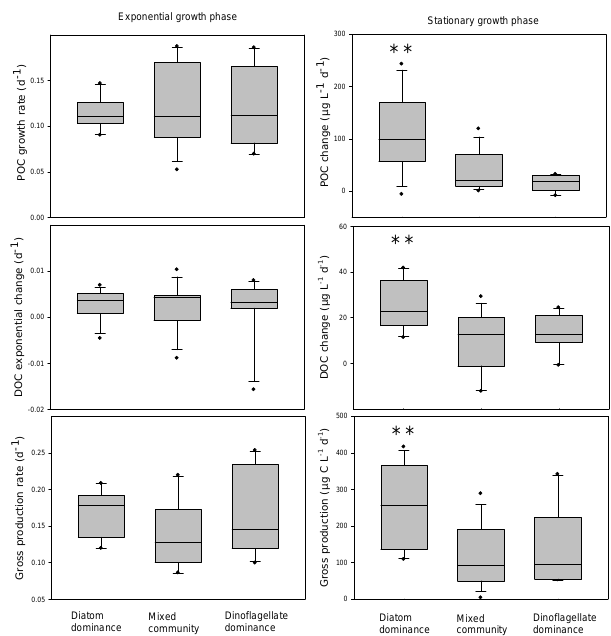
Figure 4. Carbon budget parameters: particulate organic carbon (POC), dissolved organic carbon (DOC), and total gross produc- tion, during exponential and stationary growth. The phytoplank- ton community was divided into three categories: diatom domi- nance (>80%), mixed community (20–70% dinoflagellates), and dinoflagellate dominance (>70%). The rationale behind setting the group boundaries was based upon the apparent difference in species evenness (Fig. 2) between these groups. The stars (*) indicate sta- tistical significance ( α = 0.05) against one (*) or two groups (**); details can be found in Tables 3 and